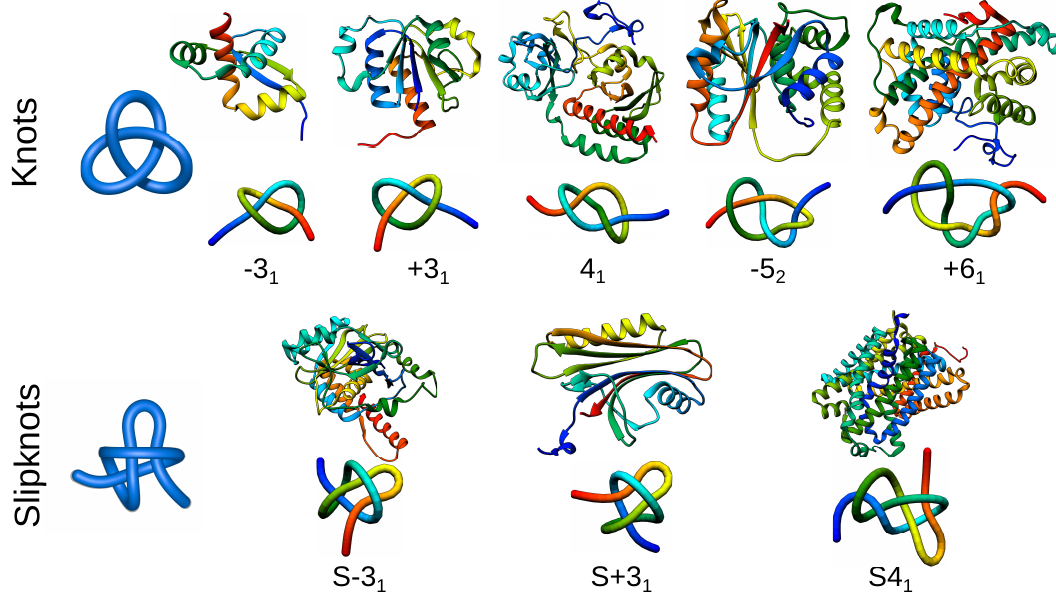
Figure 2. Different types of knotted topologies identified in proteins to date. For each knot/slipknot, its type is indicated by an exemplary structure along with a scheme of its topology. The letter S indicates that the entire polypeptide chain of a given protein forms a slipknot. The type of knot and its chirality (positive or negative) are shown below the schematic figures. PDB IDs of knotted structures from left to right: 2efv, 1j85, 4y3i, 3irt, 3bjx; for slipknotted structures (left to right): 1hyn, 2qqd,